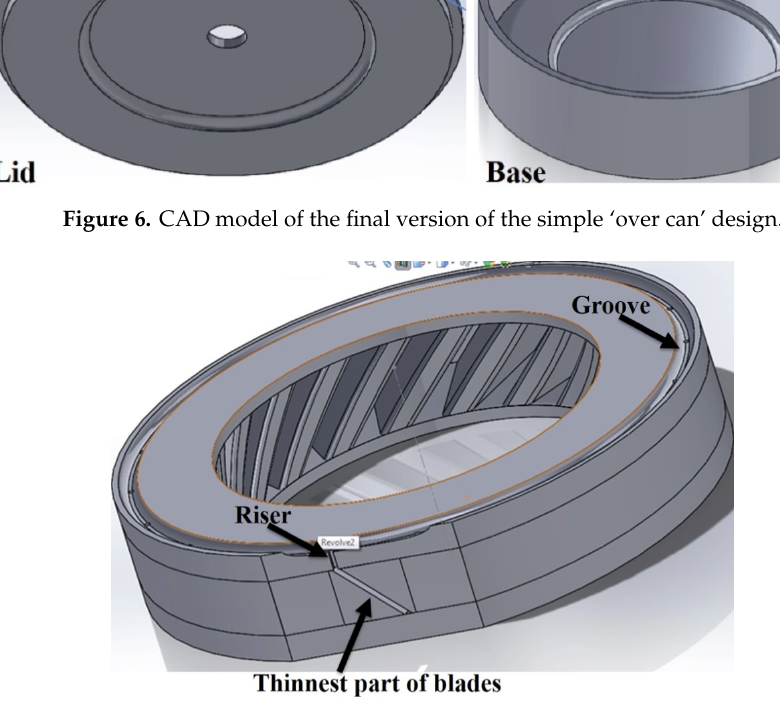
Figure 7. CAD model of the final version of the SLM-processed blade tooling.